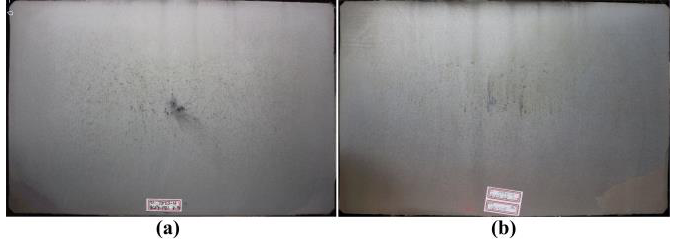
Figure 15. Macrographs: ( a ) before optimal control; ( b ) after optimal control.